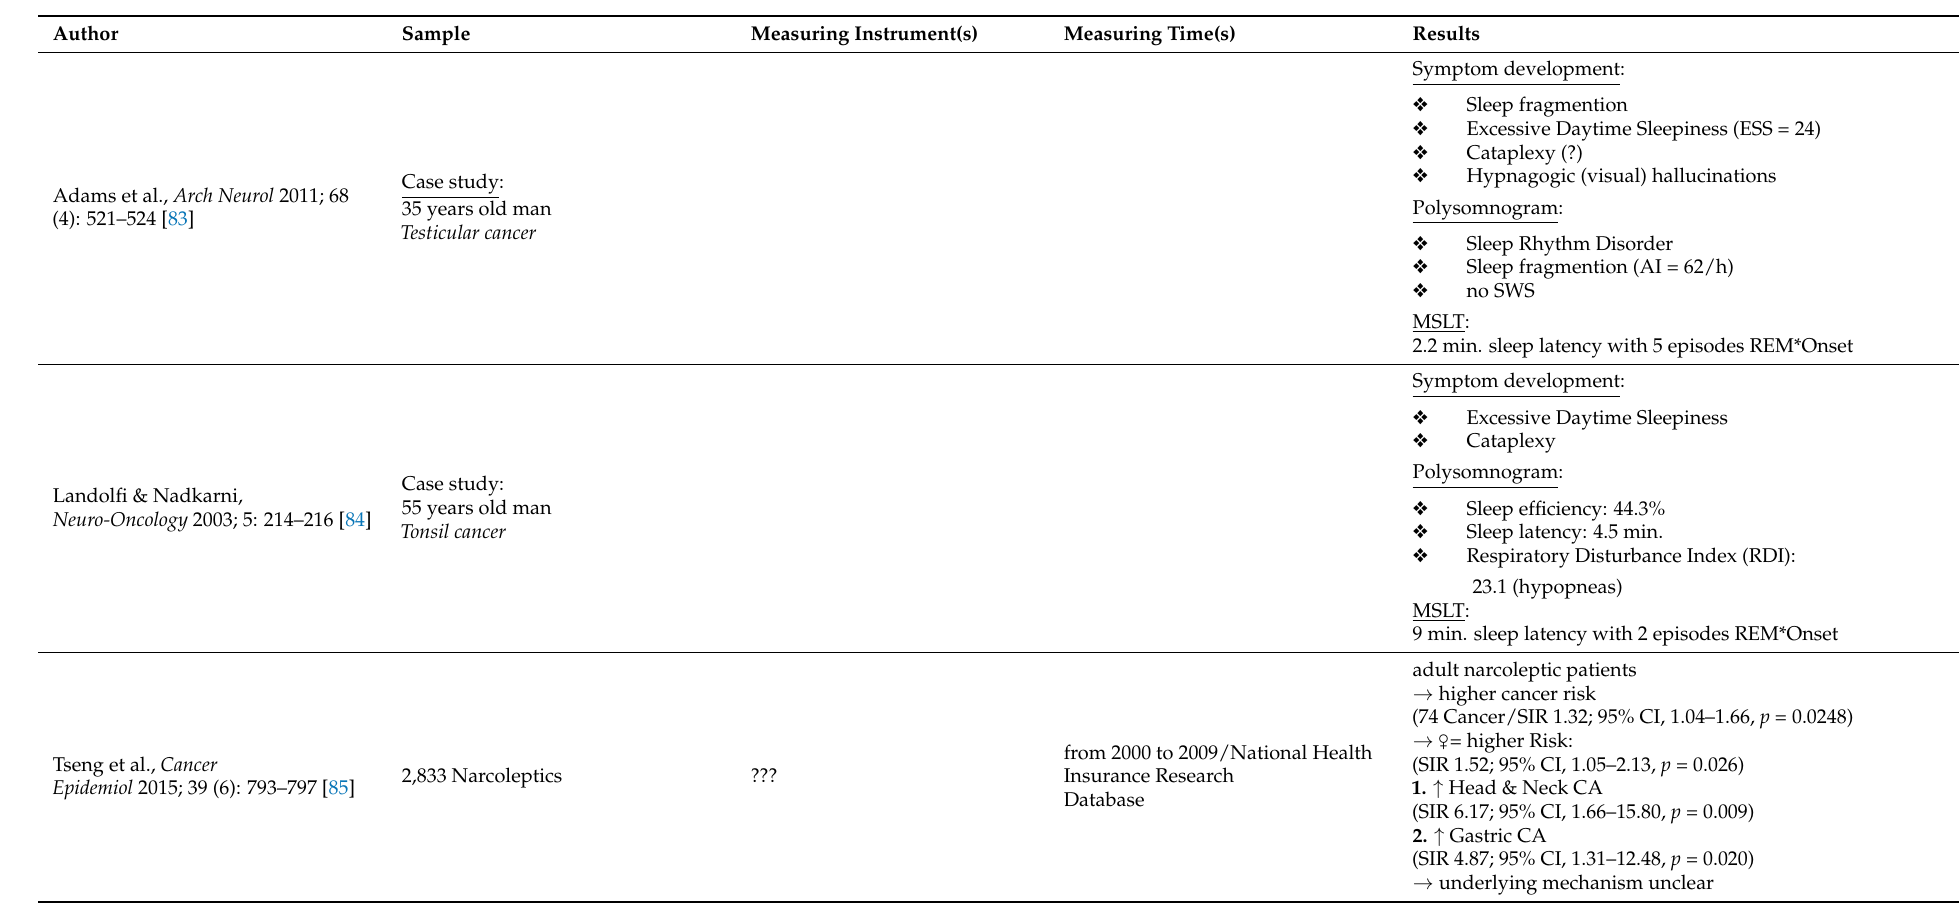
Table 7. Studies on Narcolepsy in